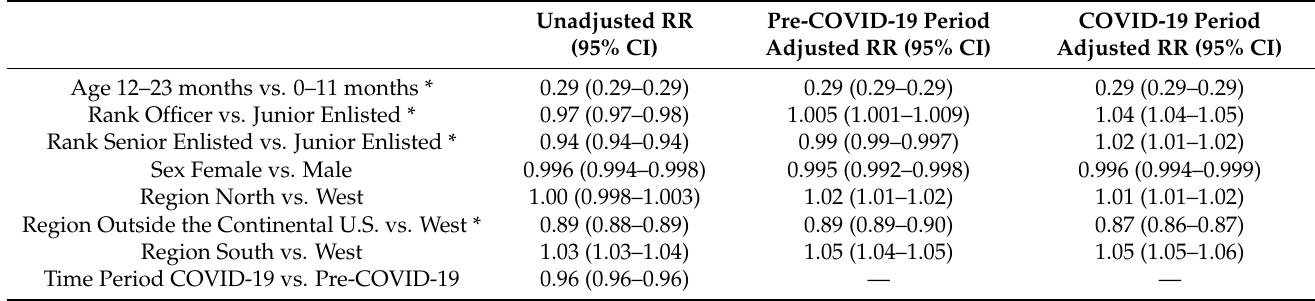
Table 5. Vaccination Rate Ratios.